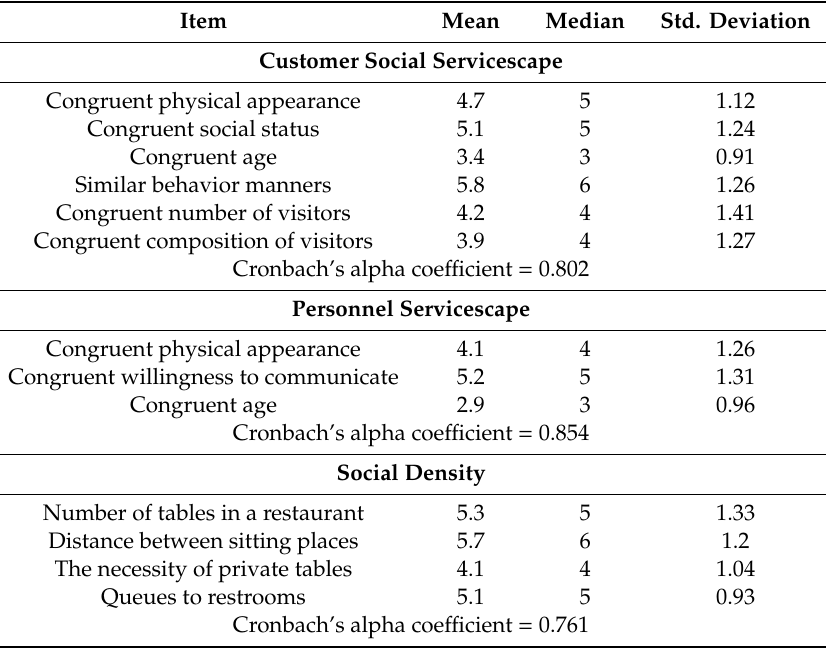
Table 1. Descriptive statistics of analyzed